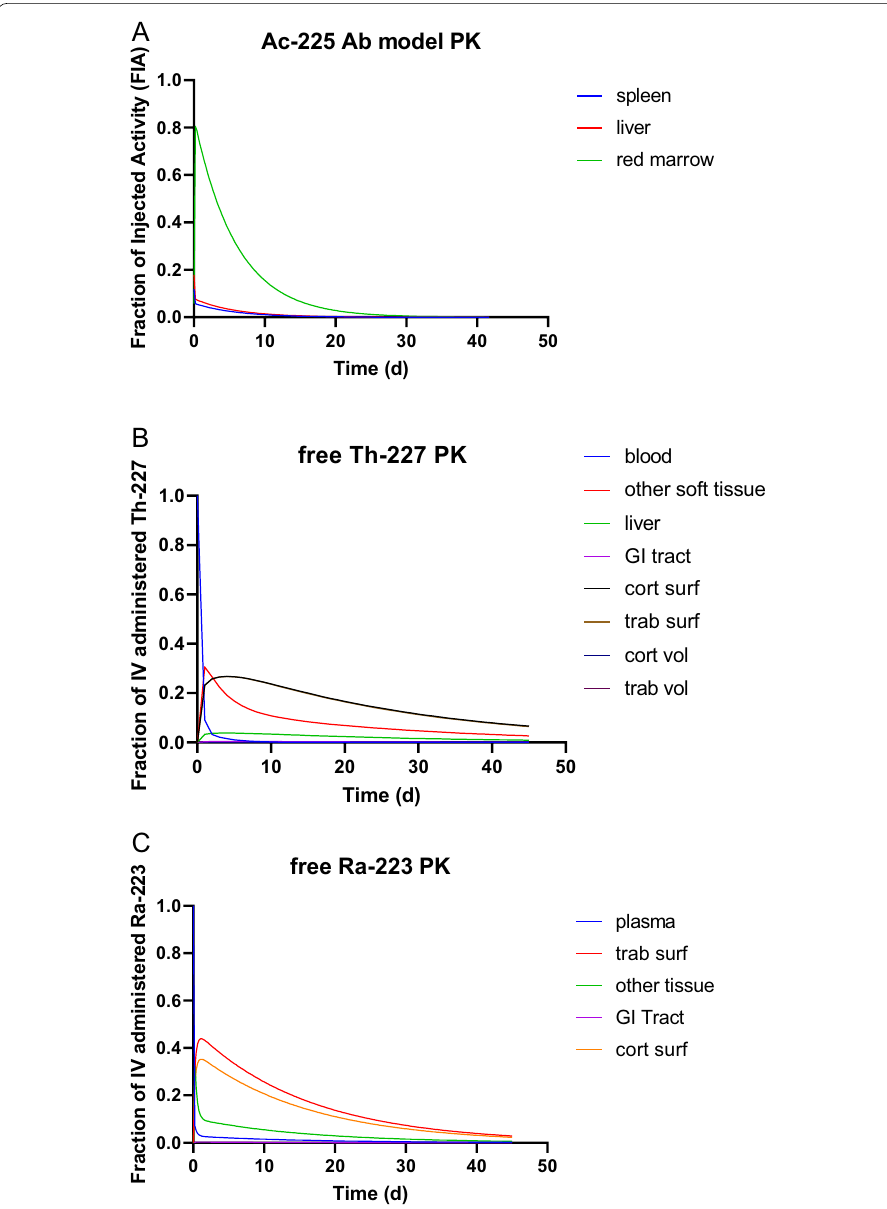
Fig. 5 Results of A Ab PK model simulations for 225 Ac-bound Ab. B PK for free 227 Th C PK for free 223